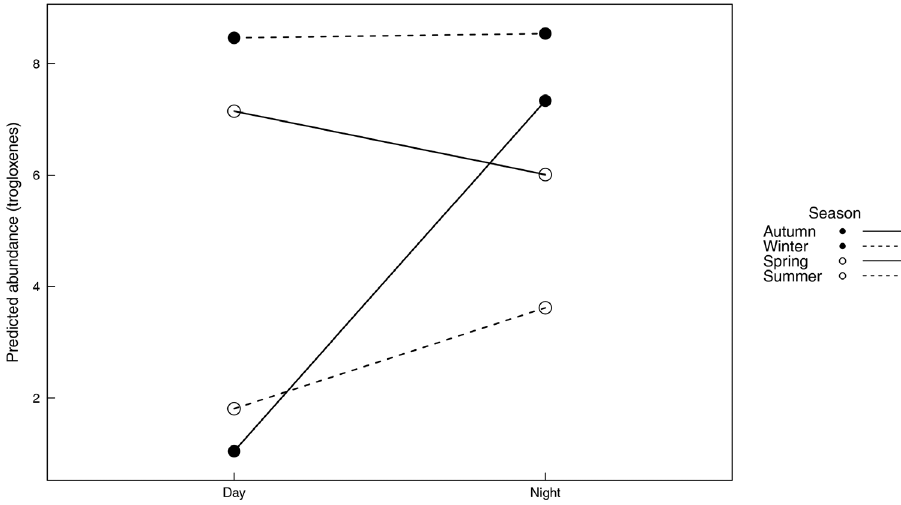
Figure 4. Interaction plot showing the effect of the interaction between seasonality and the day–night cycle on the abundance of